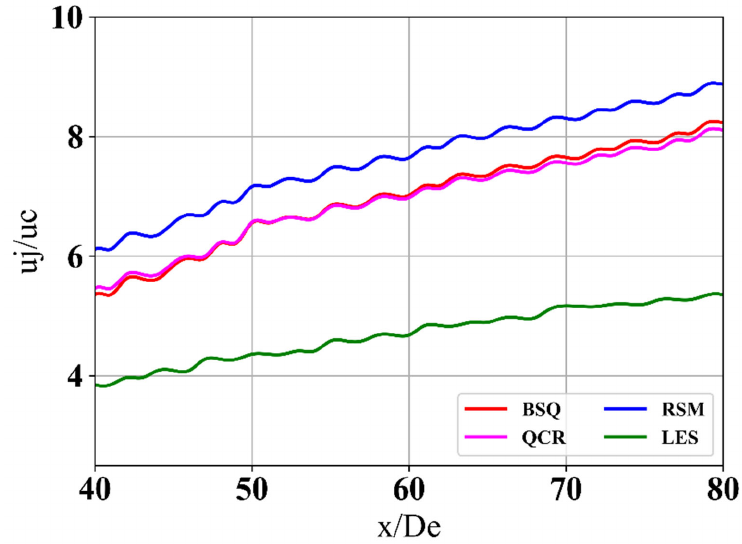
Figure 19 . Centerline profiles of inverse of streamwise velocity. Figure 19. Centerline profiles of inverse of streamwise velocity.